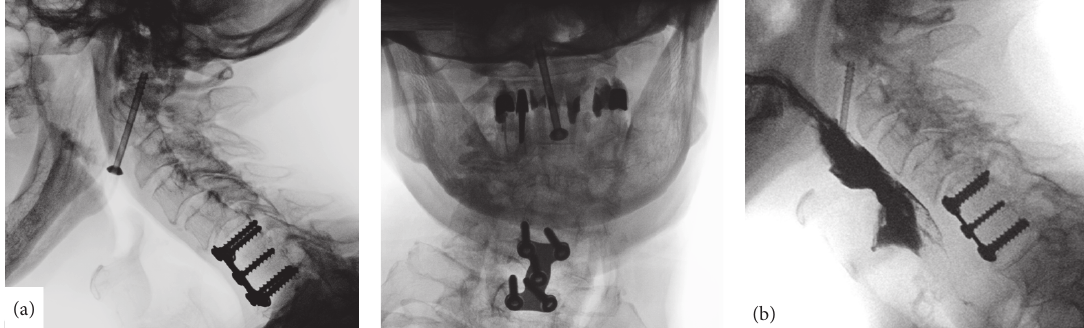
Figure 2: (a) X-ray imaging disclosed a ventral migration of the odontoid screw, 8 years after operation, lateral view (left) and a.p. view (right). (b) Pharyngeal stenosis was excluded by fluoroscopic swallow examination, lateral view.